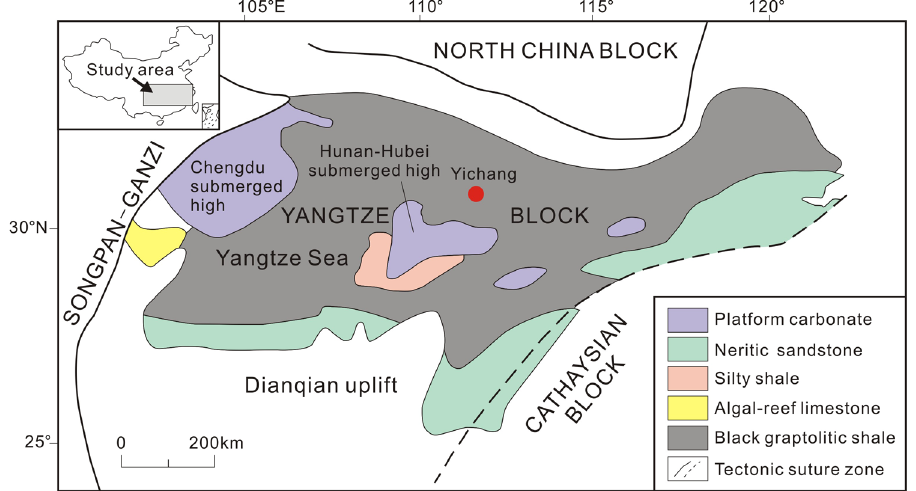
Figure 1. Palaeogeographic map of Yangtze block area during the Late Ordovician. Modified from Zhou et al . 34 . The study sections are at Yichang, South